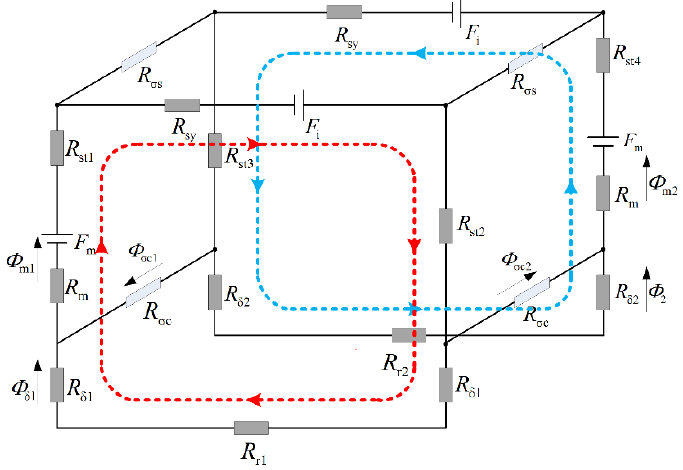
Figure 3. The 3D-equivalent magnetic-circuit model of fundamental analysis unit of TF − CFRM.